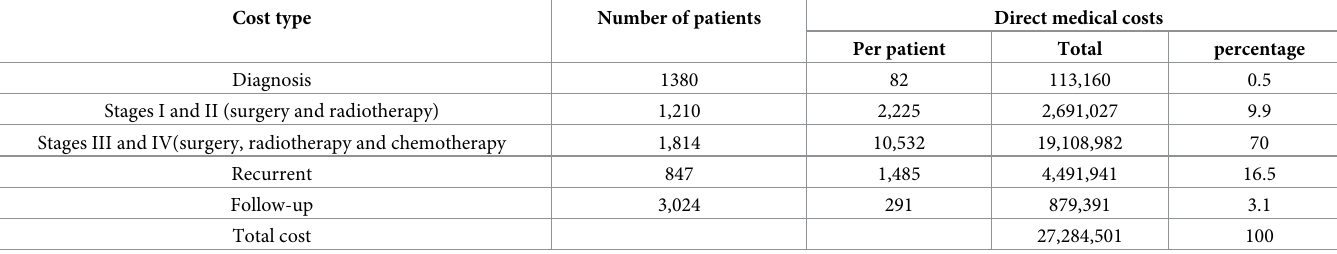
Table 2. The direct costs of oral cancer management in Iran in